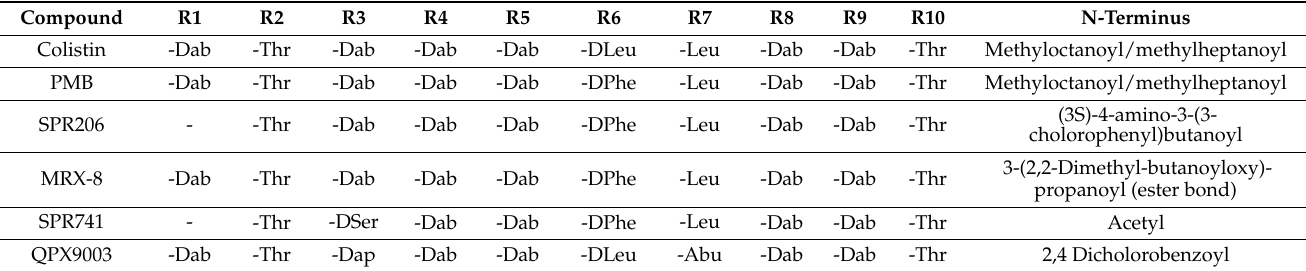
Table 1. The structure of colistin, polymyxin B, and new polymyxin